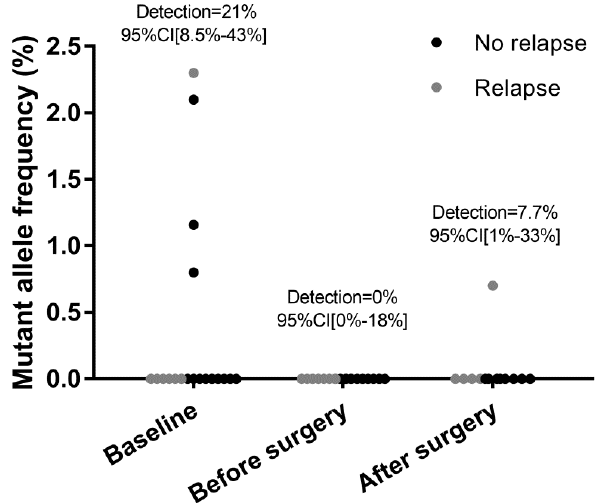
Figure 2. Circulating tumor DNA detection according to time point (baseline, before surgery, after surgery) by droplet digital